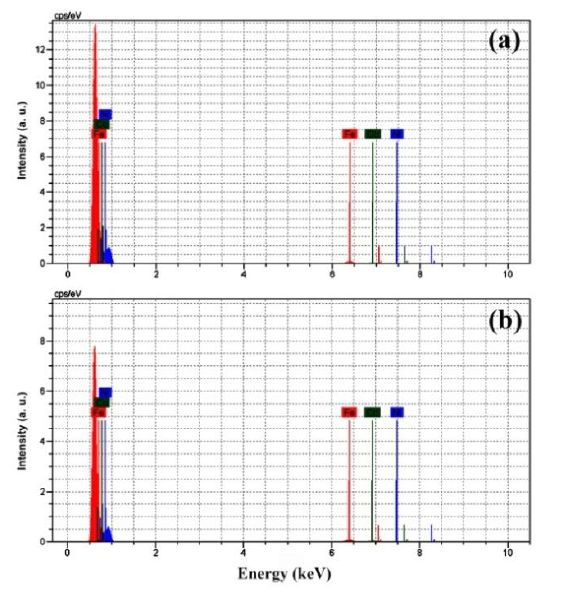
Fig. 4. EDS patterns of FeCoNi nanowire arrays with lengths of (a) 32 and (b) 14  m. Table 1. Compositional characterization of FeCoNi nanowire arrays with lengths of 32 and 14 